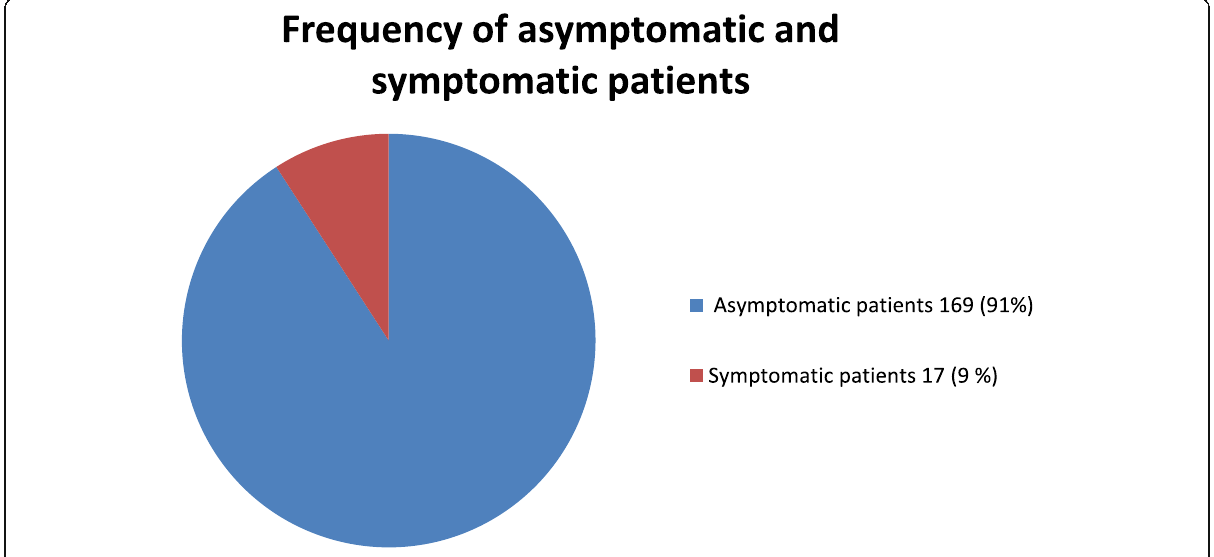
Fig. 4. Frequency of asymptomatic and symptomatic hemangioma